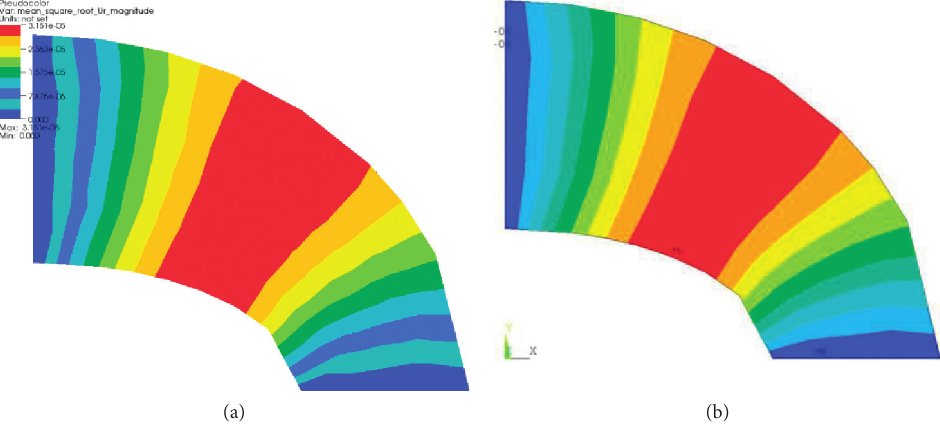
Figure 12: Comparison of RMS displacement fringes.